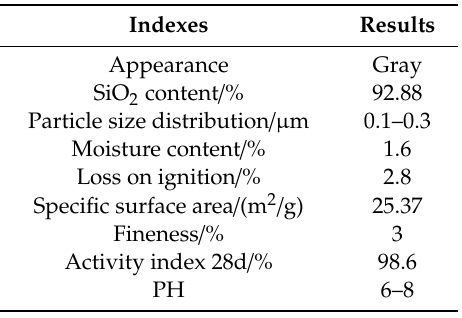
Table 1. Main technical indicators of SF (silica fume).